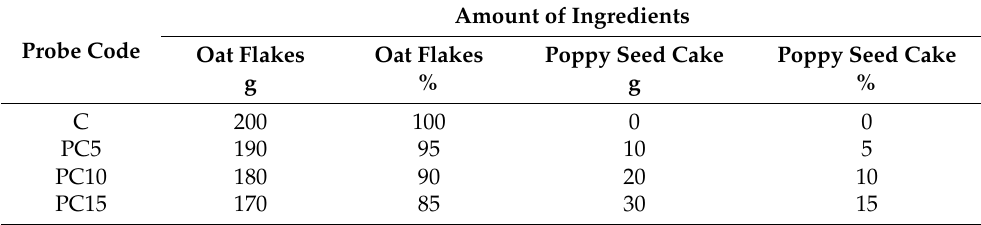
Table 1. Model of experiment parameters.